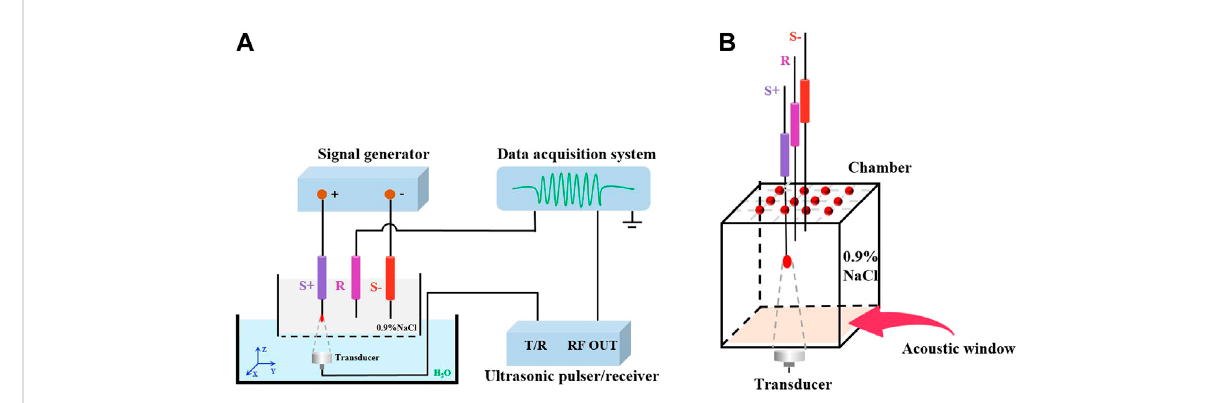
FIGURE 1 (A) Schematic of experimental setup. (B) Detail of the chamber.